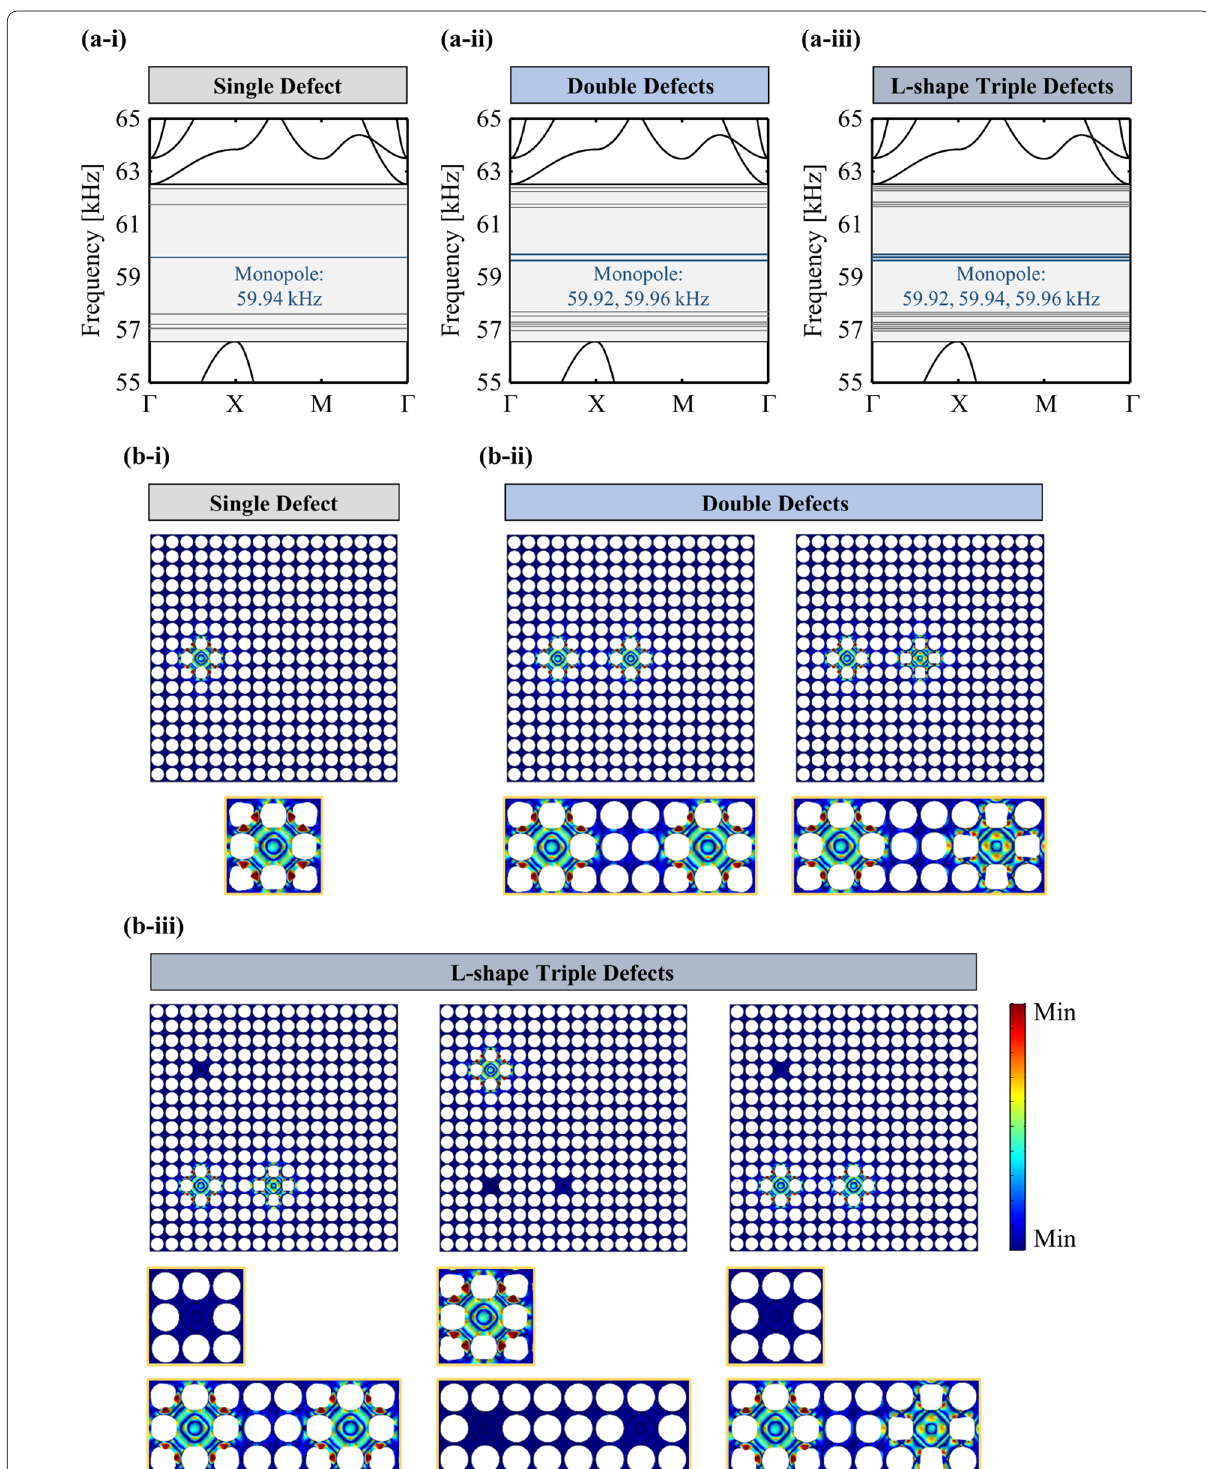
Fig. 3 Defect‑band results under short‑circuit in the band‑structure analysis: defect‑band formation in the cases of a ‑ i single defect, a ‑ ii double defects, and a ‑ iii the proposed L‑shape triple defects, and the monopole‑like defect‑mode shapes of b ‑ i single defect, b ‑ ii double defects, and b ‑ iii the proposed L‑shape triple